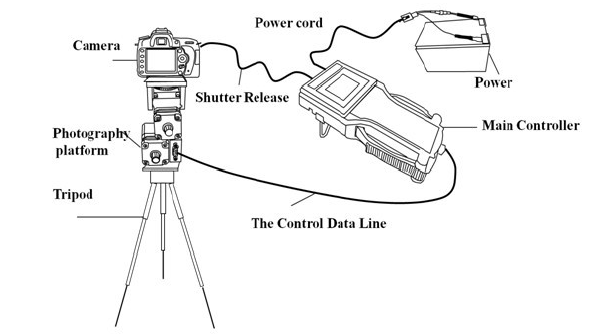
Figure3. the structure of photograph